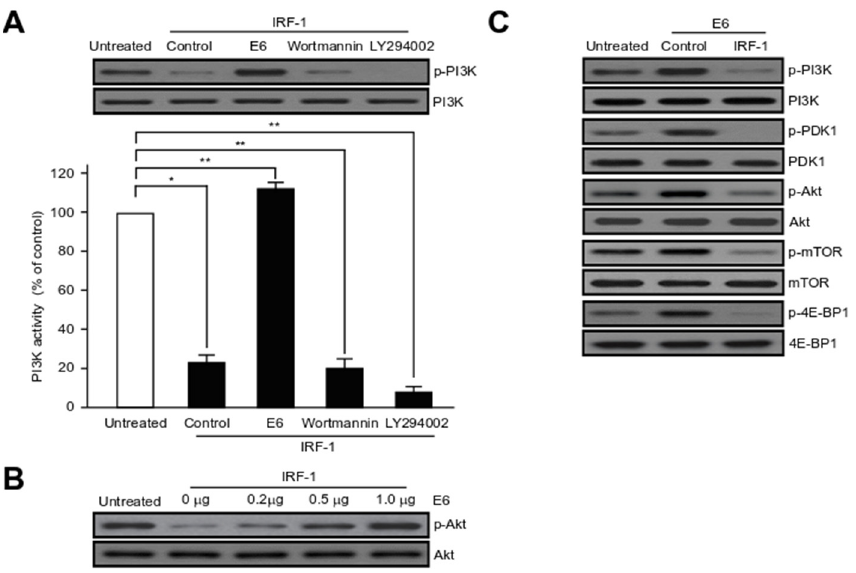
Figure 6. HPV16 E6 oncoprotein enhances PI3K/mTOR phosphorylation. ( A ) The effect of HPV16 E6 on PI3K activity in the presence of IRF-1 was evaluated using an in vitro PI3 kinase assay system. As shown in the graph, the transfected cells with IRF-1 were transfected or treated with the control, HPV16 E6 expression plasmid, Wortmannin or LY294002 for 24 h, and harvested and immunoblotted to measure the indicated levels of protein expression. PI3K served as a protein loading control. All experiments were repeated at least three times with similar results. Protein bands were evaluated via densitometric analysis and normalized to levels of the loading control; * p < 0.05; ** p < 0.01 compared with control. ( B ) IRF-1-expressing cells were transfected with various concentrations of the HPV16 E6 expression plasmid. Phosphorylation of Akt was detected by immunoblotting analysis. Protein band for non-phosphorylated Akt ensured equal loading of the samples. All experiments were performed at least three times with consistent and similar results. ( C ) Cells were transfected with the untreated, HPV16 E6 (control) or HPV16 E6 plus IRF-1. The total cells were harvested and treated with lysis buffer. After centrifugation, equal amounts of protein (20~25 μ g) were separated on 8~12% SDS-PAGE, followed by immunoblotting analysis with specific antibodies (PI3K/phosphorylated PI3K, PDK1/phosphorylated PDK1, Akt/phosphorylated Akt, mTOR/phosphorylated mTOR, and 4E-BP1/phosphorylated 4E-BP1). All experiments were conducted at least three times with consistent and similar results. Non-phosphorylated form (indicated PI3K, PDK, Akt, mTOR, and 4E-BP1) and β -actin ensured equal loading of the samples.